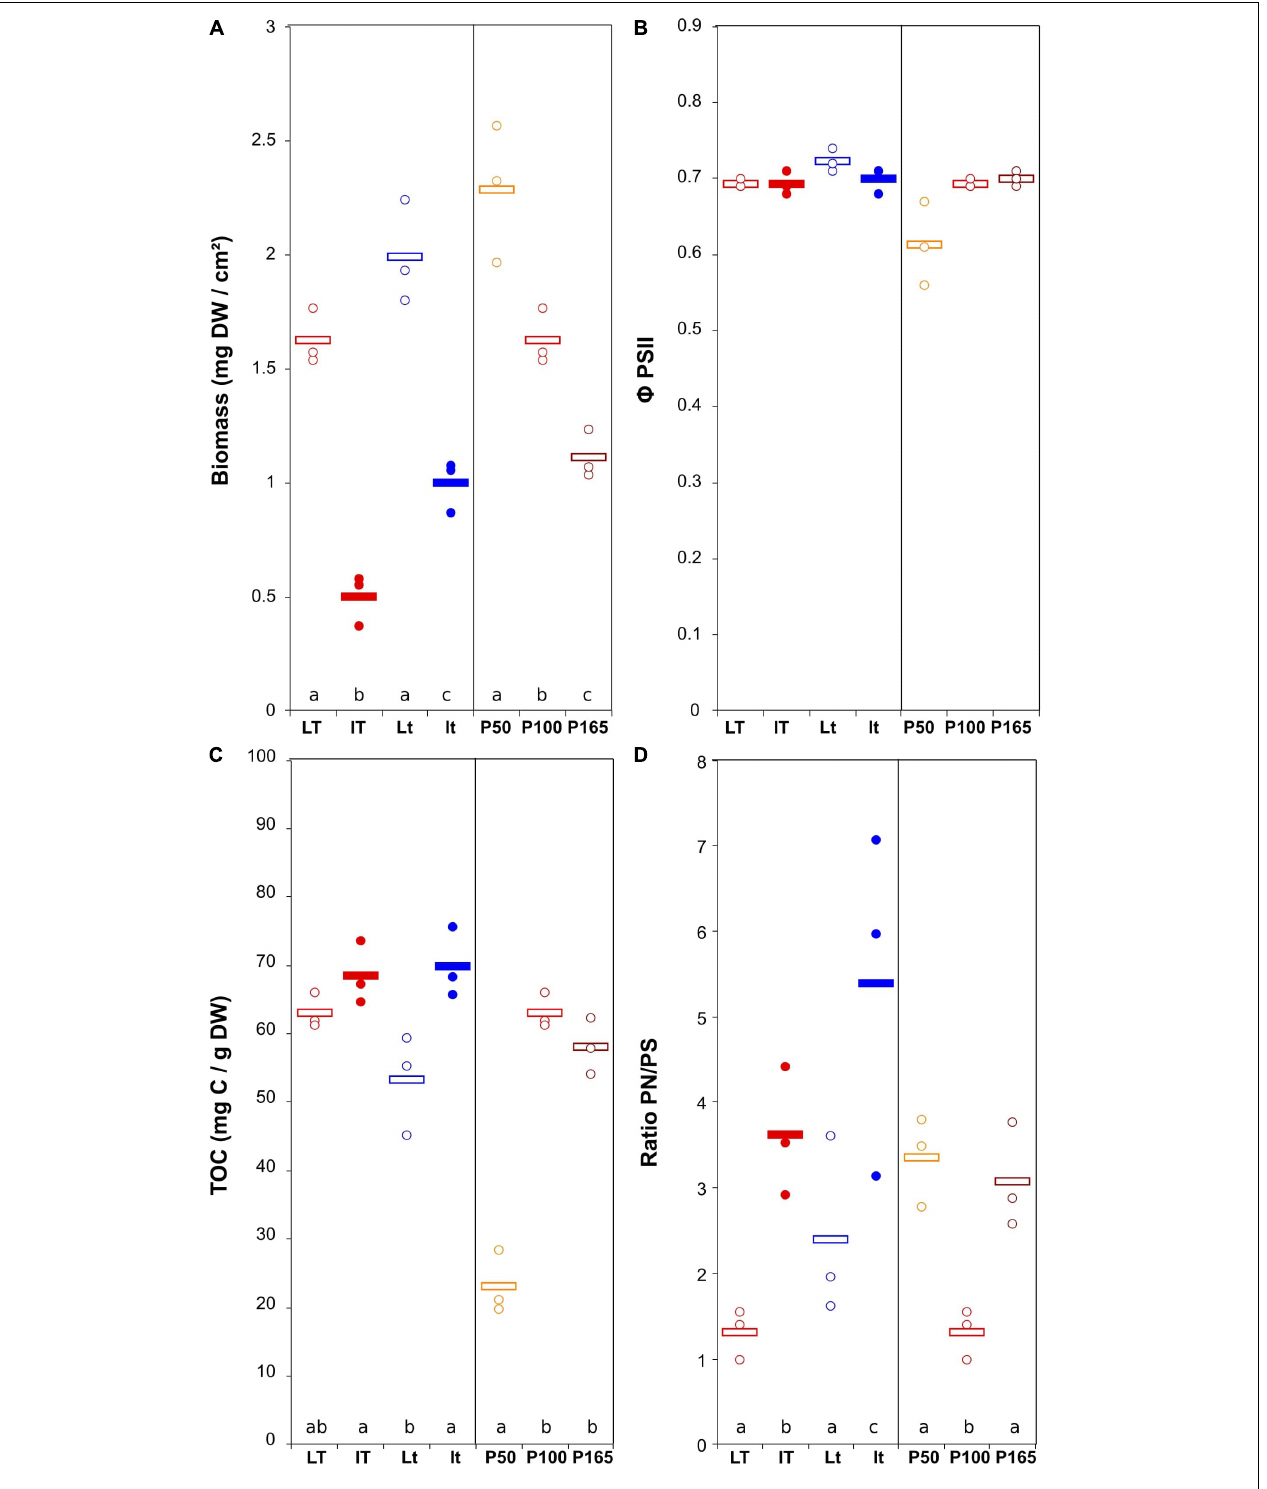
FIGURE 3 | Scatter plot of the biomass ( DW = dry weight) (A) , maximum quantum yield (B) , total organic carbon (quantity of EPS) (C) , and ratio protein/polysaccharide in the EPS (D) in U. confervicolum biofilm before the disturbance. The letters indicate statistically homogeneous groups (Tukey post hoc test after ANOVA). No letters for non-significant ANOVA (the bars represent the means, n = 3). L / l : high/low light intensity (P100), T / t : high/low temperature (P100), P50, P100, P165: 50, 100, and 165% of the standard initial phosphorous concentration, respectively, associated with L and T conditions.